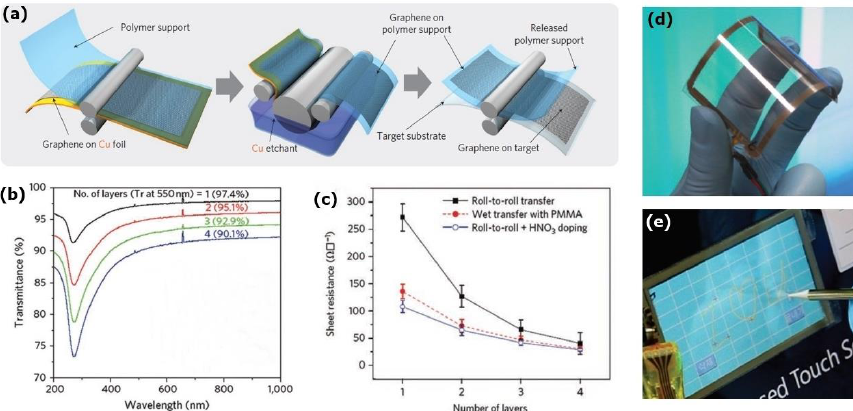
Figure 11. ( a ) Schematic of the roll-to-roll production process of 30” flexible polymer foils with a graphene electrode. ( b ) The transmittance of the transparent and flexible electrode depends on the number of graphene layers, decreasing for increasing graphene film thickness. ( c ) At the same time, the sheet resistance decreases for increasing graphene film thickness, illustrating the trade-off that needs to be managed. In the given example, a 3-layer film is probably the best compromise between high transmittance and low sheet resistance, approaching the performance of ITO electrodes. ( d ) Visual example of a transparent flexible assembled touch panel from graphene/PET, and ( e ) graphene-based touch screen with computer control (Reproduced by permission from [121]).